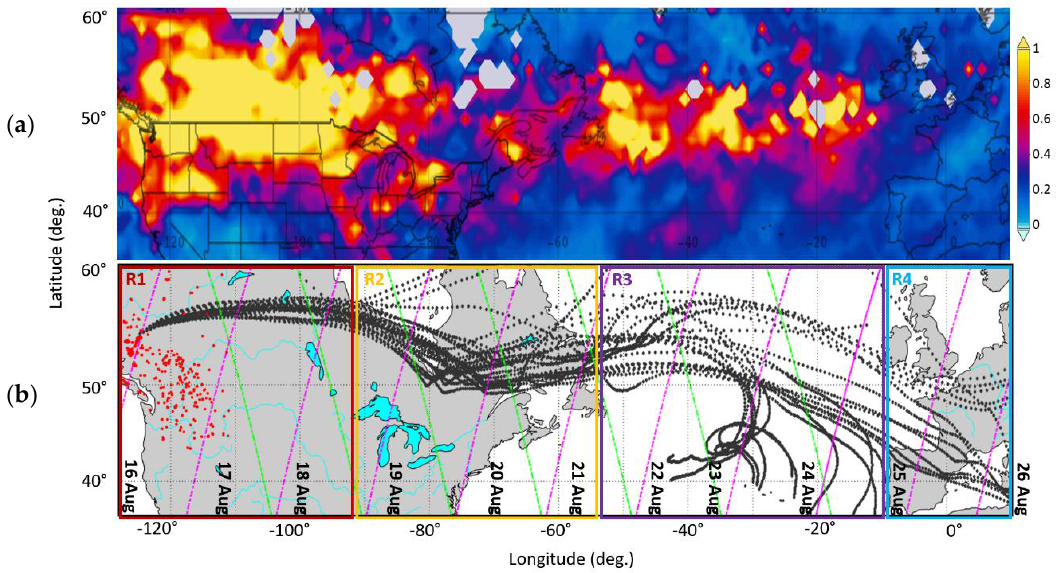
Figure 1. ( a ) Time Averaged Map of Combined Dark Target and Deep Blue AOD at 550 nm for land and ocean: Mean daily 1° [MODIS-Aqua MYD08_D3 v6.1] from 16 August 2018 and for a 10 day period. ( b ) The 10 day forward HYSPLIT trajectories starting on 16 August and ending on 10 August. The red dots correspond to active fires observed in BC, Canada, by MODIS with confidence greater than 80%. Magenta and green lines correspond to nighttime and daytime CALIPSO orbits, respectively. Red, yellow, purple and cyan boxes correspond to the four subregions (R1–R4) of the smoke motion that will be further analyzed in Section 3.2.